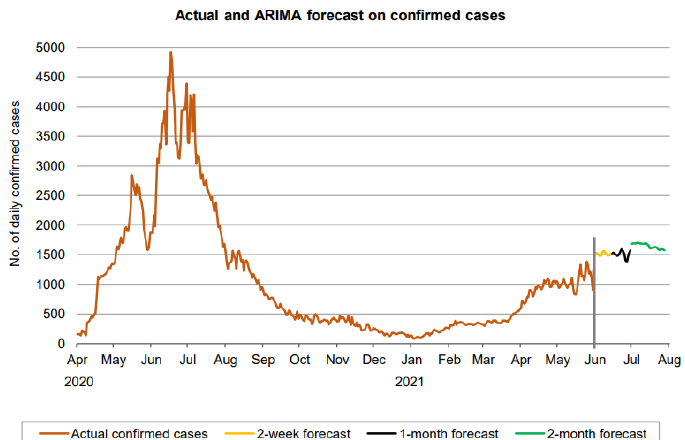
Figure 11. Prediction over a 60-day forecast for the confirmed cases using the ARIMA model. Figure 12 indicates that the number of daily new recovered cases (based on 60-day ahead forecasts) resides in the approximate range between 1000 and 1800. The forecast curve shows an increasing trend during the first 2 weeks and then takes a dive at the start of the next period (black part of the curve) before resuming the increasing trend again after. However, the growth starts declining in the final phase of the 60 days.